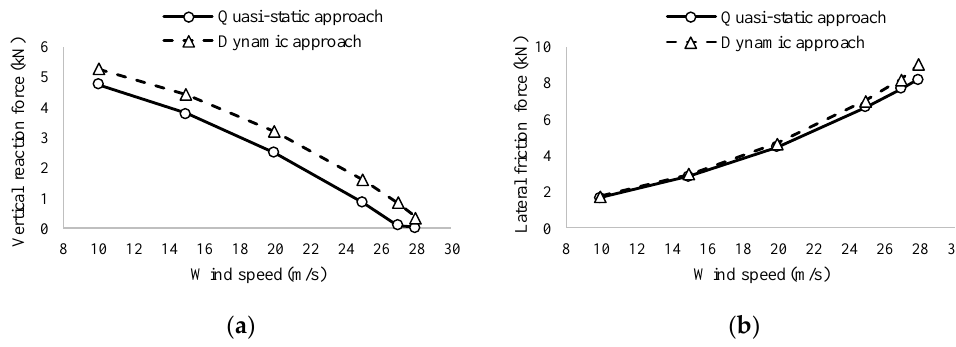
Figure 6. Tire forces of windward front axle of the van in uniform wind for: ( a ) vertical reaction force, ( b ) lateral friction force.